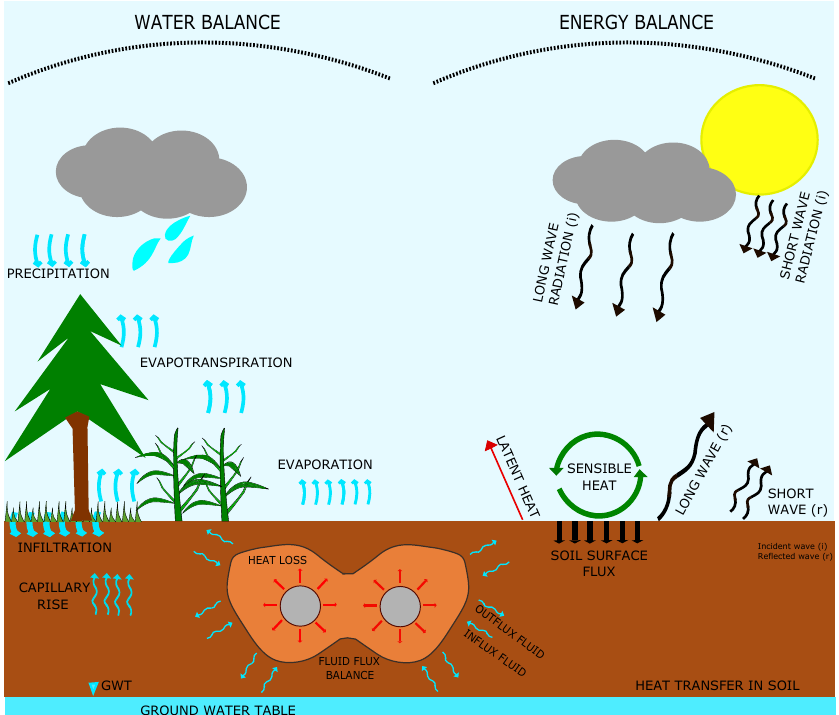
Figure 1. Interaction of underground power cables with surrounding soil and environments and different modes of heat and mass transfer in the soil